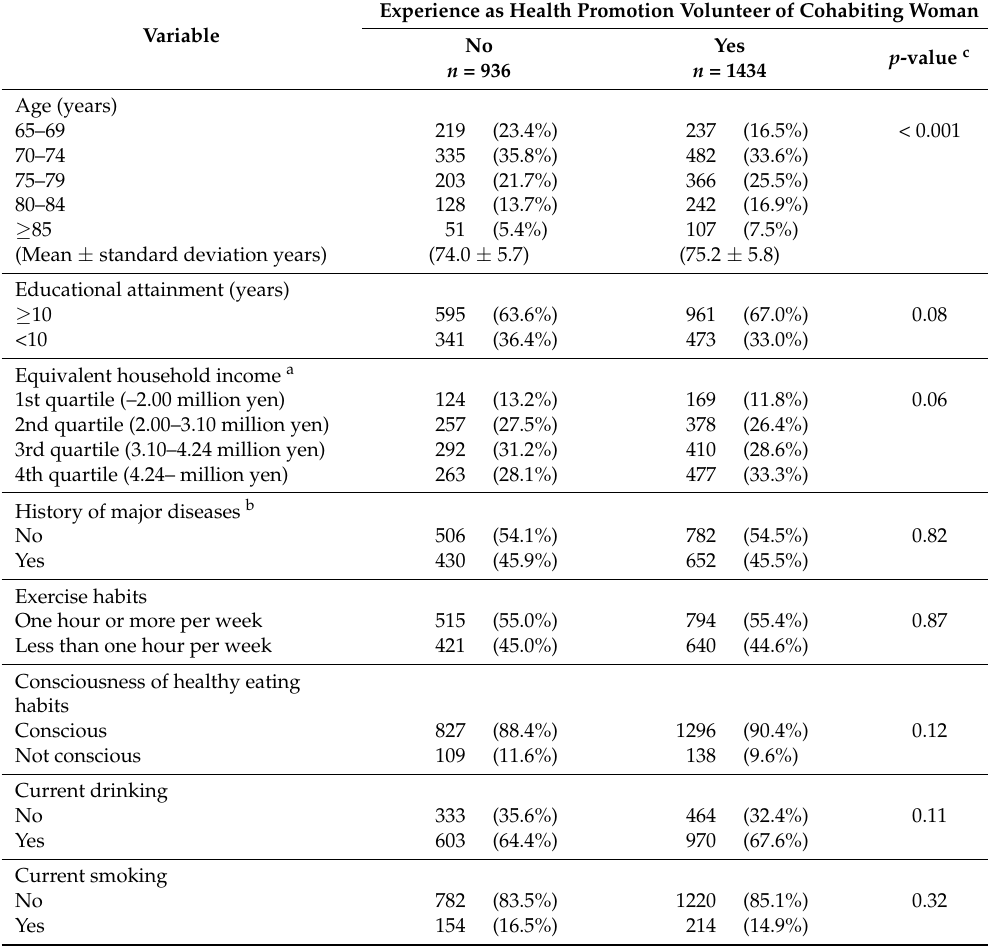
Table 1. Characteristics of the study